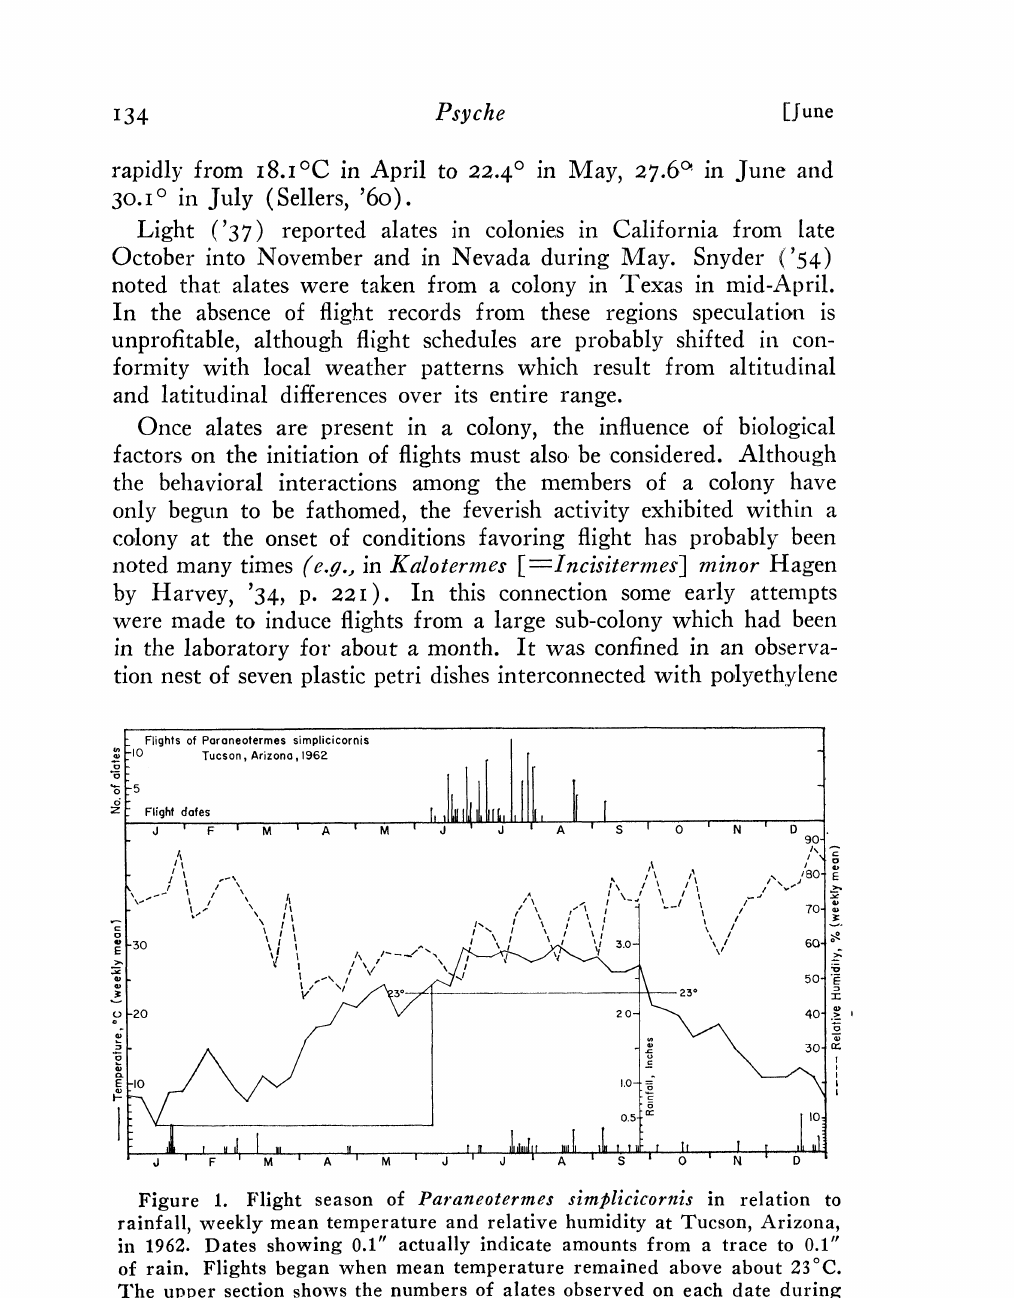
Figure 1. Flight season of Paraneotermes simlicicornis in relation to rainfall, weekly mean temperature and relative humidity at Tucson, Arizona, in 1962. Dates showing 0.1" actually indicate amounts from a trace to 0.1" of rain. Flights began when mean temperature remained abo.ve about 23C. The upper section shows the numbers of alates observed on each date during the flight season from June 9 to Sept.